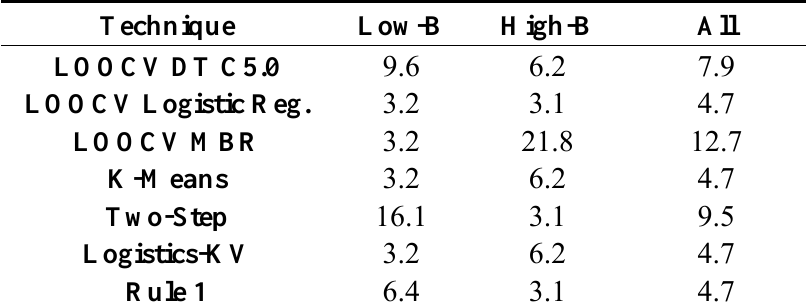
Table 3. Percent Misclassification from Binary